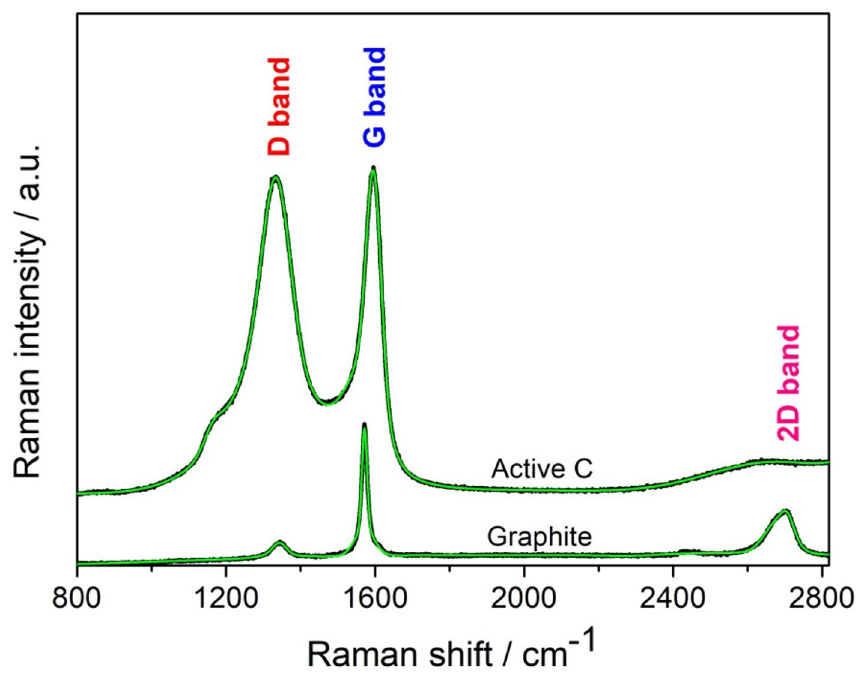
Figure 4. Raman spectra of graphite and active C materials with their Gaussian fits (green) in order to determine the band